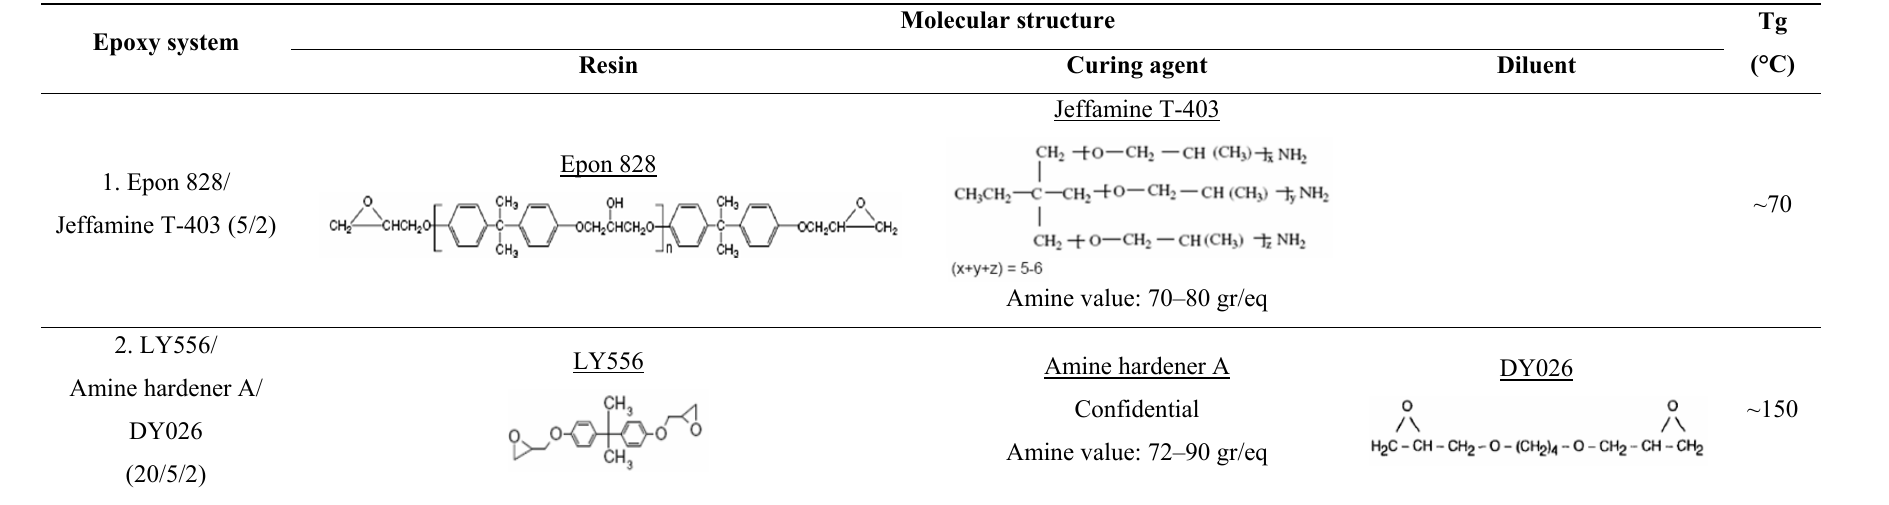
Table 3. Epoxy systems